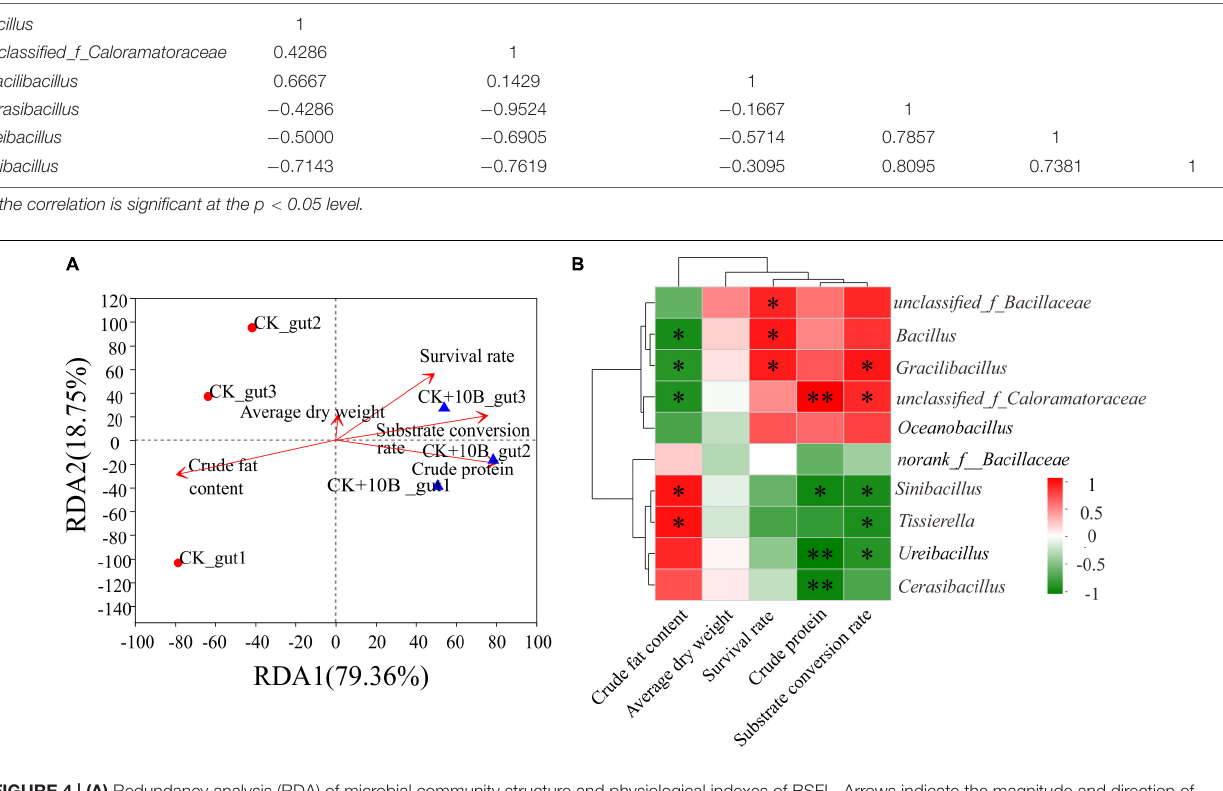
FIGURE 4 | (A) Redundancy analysis (RDA) of microbial community structure and physiological indexes of BSFL. Arrows indicate the magnitude and direction of measurable variables correlated to microbial community structure. (B) Pearson’s correlation between the relative abundance of physiological indexes and the 10 most dominant microbes in gut microbes of the CK and CK + 10B groups. CK, natural BSFL fed on non-sterile food waste; CK + 10B, natural BSFL fed on non-sterile food waste and 10B. The symbol ∗∗ means the correlation is significant at the p < 0.01 level. The symbol ∗ means the correlation is significant at the p < 0.05